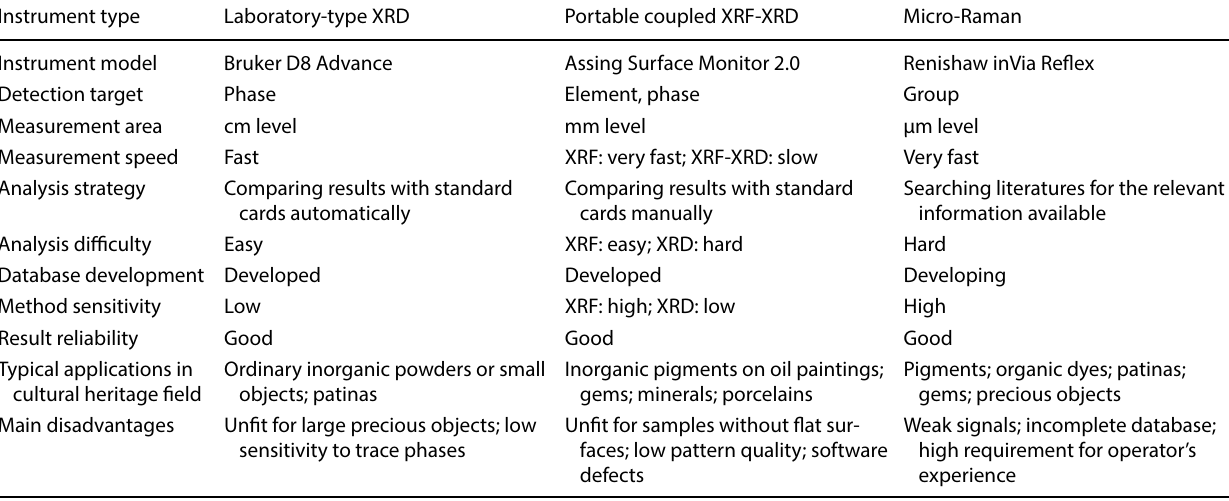
Table 4 Comparison of laboratory-type XRD, portable coupled XRF-XRD and micro-Raman techniques Instrument